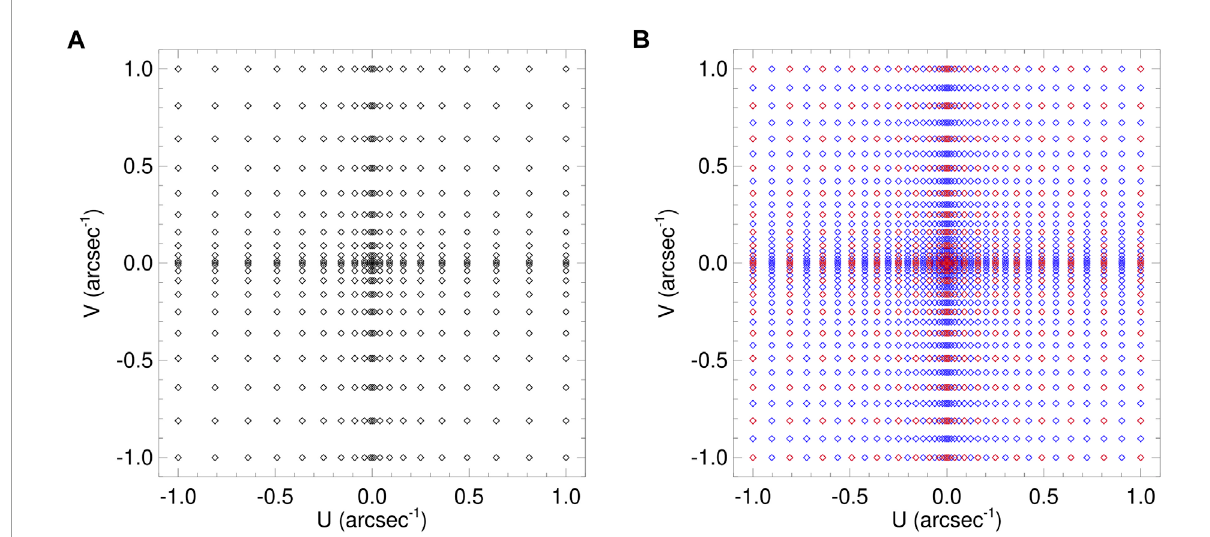
FIGURE 4 Spatial frequency points at which visibility information is computed. Two sets of sampled points are shown. (A) A relatively coarse 21 × 21 grid; (B) a finer 39 × 39 grid. In panel (B) we plot the 39 × 39 grid in blue and, for comparison, we overlay the 21 × 21 grid in